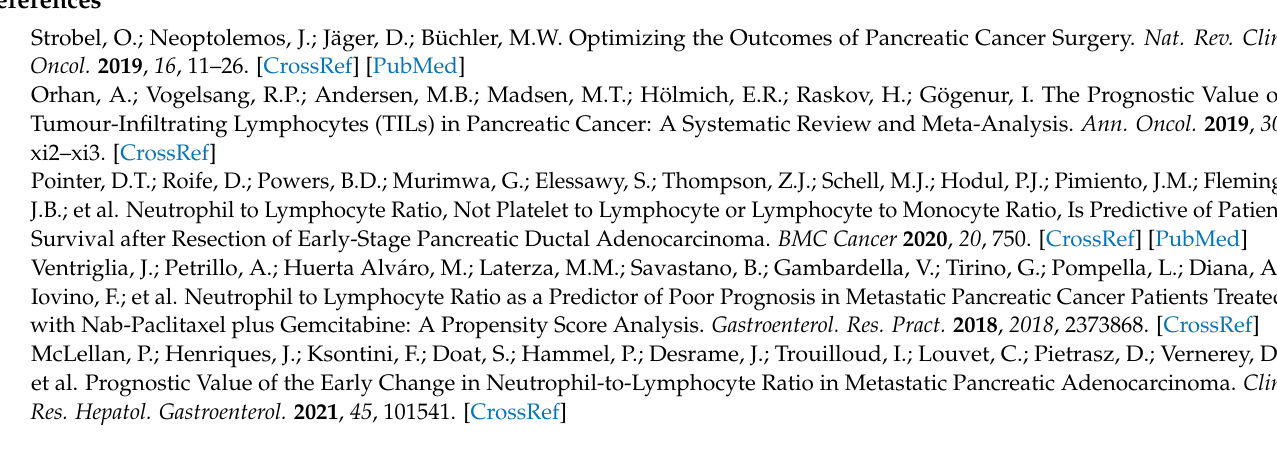
Table S2: Descriptive statistics of study cohort with respect to PLR; Table S3: Descriptive statistics of study cohort with respect to LMR; Table S4: Descriptive statistics of study cohort with respect to CAR; Table S5: Descriptive statistics of study cohort with respect to IBI; Table S6: Different inflammation- based parameters; Table S7: Univariate and multivariate logistic regression analyses scores from Table